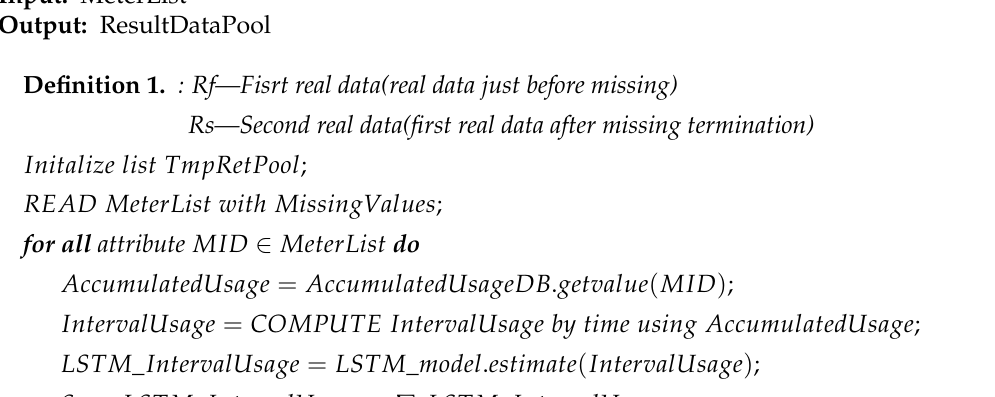
Algorithm 1 Weighted LSTM